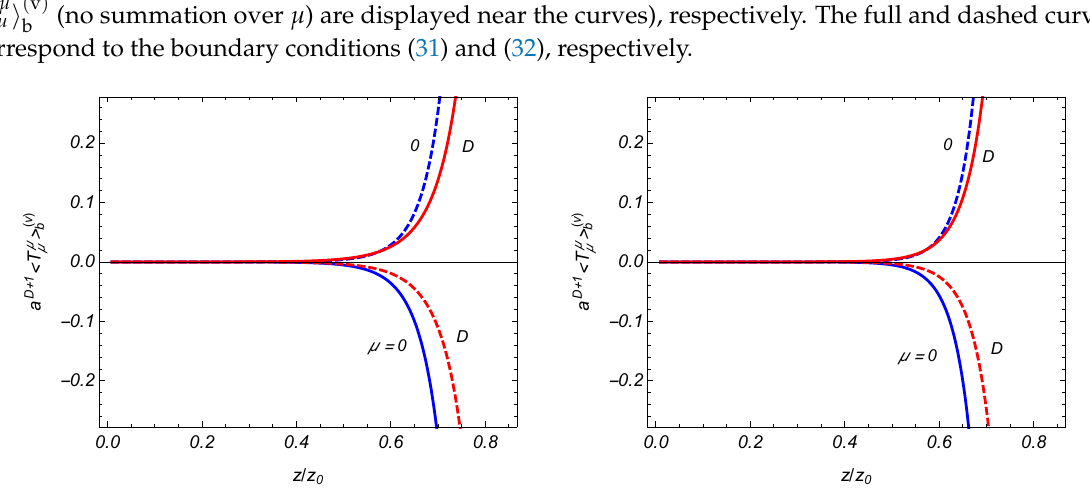
Figure 7. The brane-induced VEVs of the energy density and the normal stress in the L-region as functions of z / z 0 for: D = 4 electromagnetic field ( left ); and D = 5 electromagnetic field ( right ). The full and dashed curves correspond to the conditions (31) and